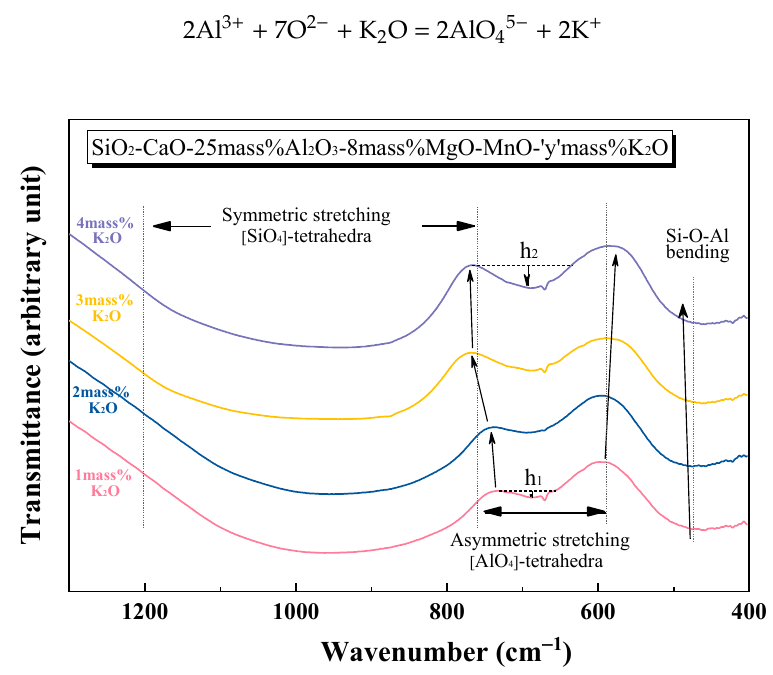
Figure 7. The effect of K 2 O on the FTIR spectra of SiO 2 –CaO–25 mass% Al 2 O 3 –8 mass% MgO–MnO– Figure 7. The e ff ect of K 2 O on the FTIR spectra of SiO 2 –CaO–25 mass% Al 2 O 3 –8 mass% K 2 O slag. MgO–MnO–K 2 O